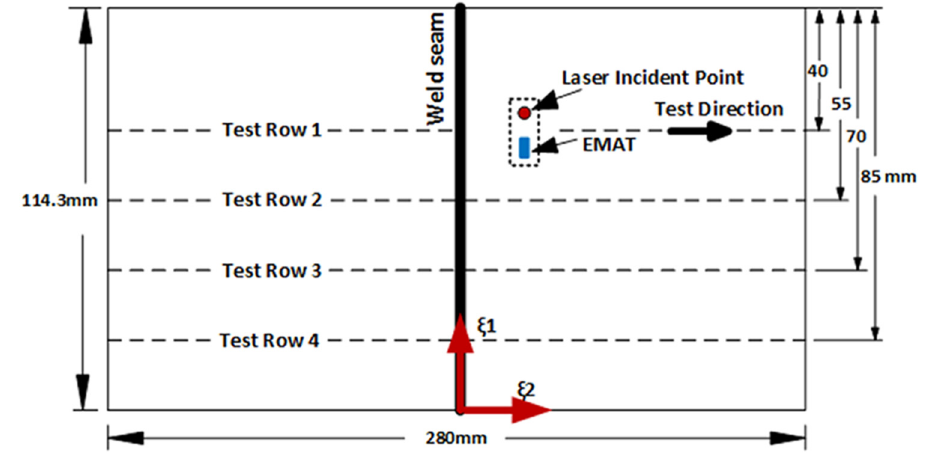
Fig. 12. Schematic diagram showing the ToF